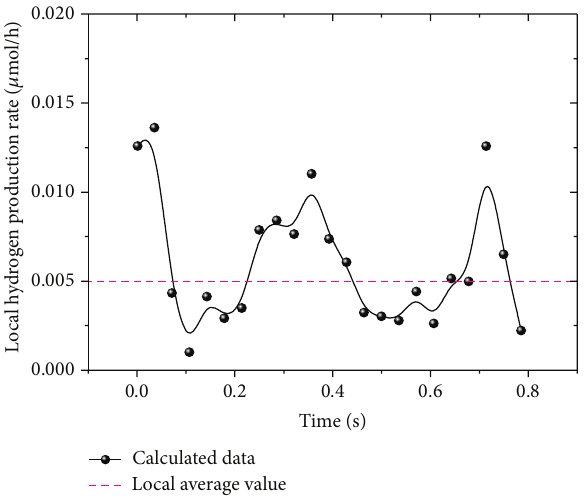
Figure 7: Calculated local hydrogen production rate (red dashed line indicates the average value in a bubble evolution